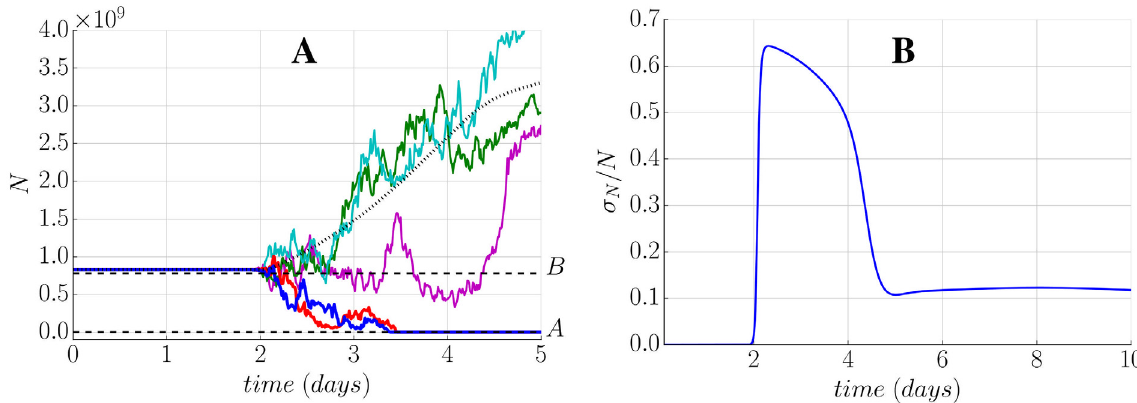
Fig 11. Noise can cause tumour spontaneous extinction during the first week. Stochastic results for the first week growth with parameters of Table 3. (A) Different realizations of the CLE. Two trajectories with a tumour disappearing (begin absorbed by state A), and three trajectories with a successful growth of the tumour, one of them begin transiently trapped around state B. Dotted line shows the deterministic evolution of the tumour. (B) Analytic relative noise intensity given by Eq